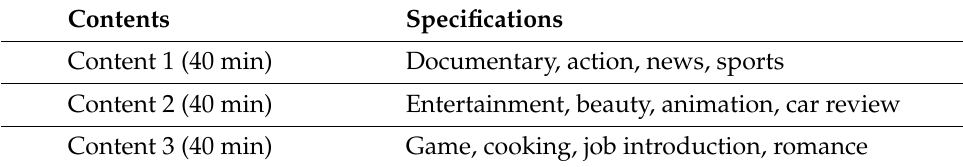
Figure 1. Proposed data simulator. Table 1. Specifications of input